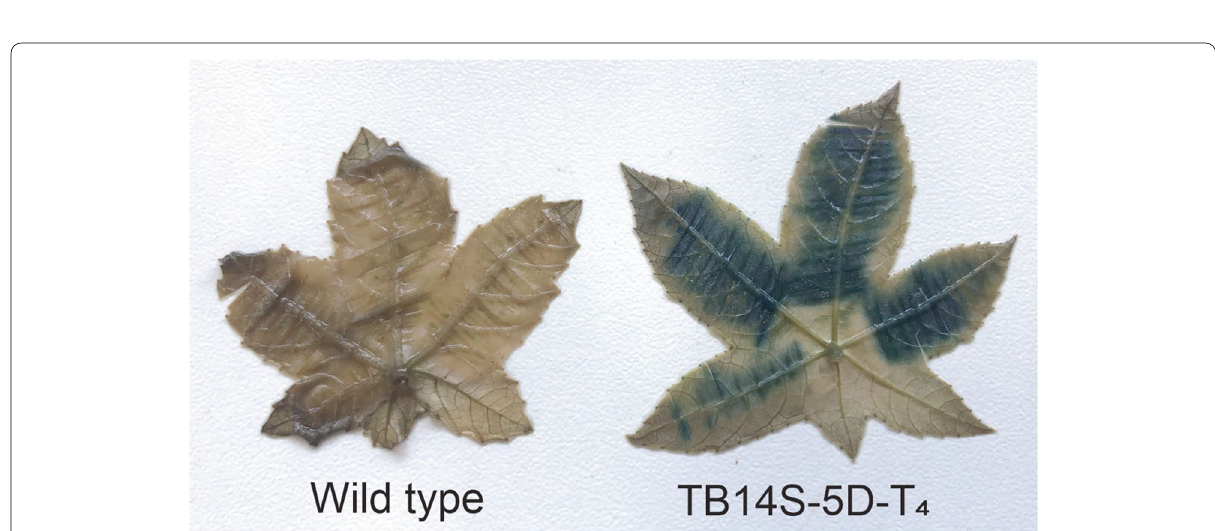
Fig. 4 Expression of the gus gene in transgenic leaf from the 4th generation of event TB14S-5D (homozygous plants). Wild type is a leaf from the non-transgenic line. Leaves were cut to assist substrate